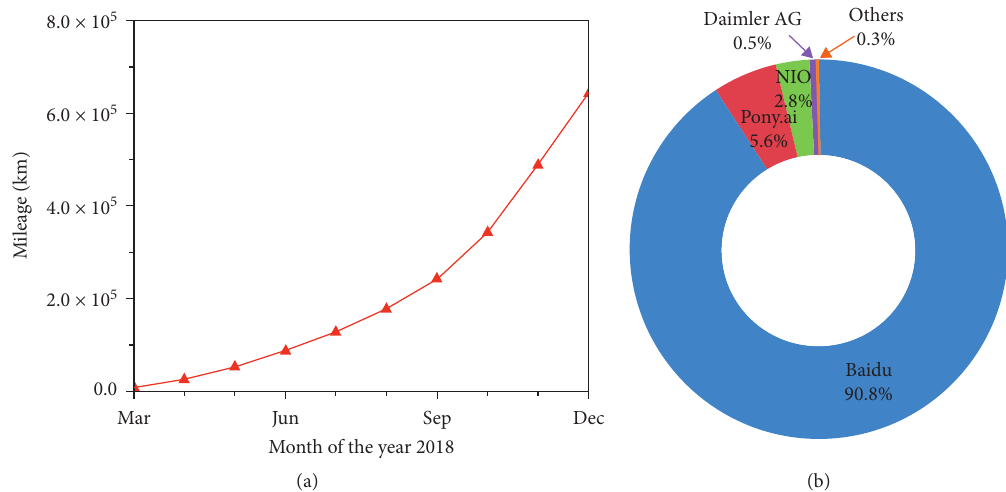
Figure 7: (a) Cumulative mileage and (b) breakdown of mileage contribution due to various manufacturers tested in Beijing in the year 2018.